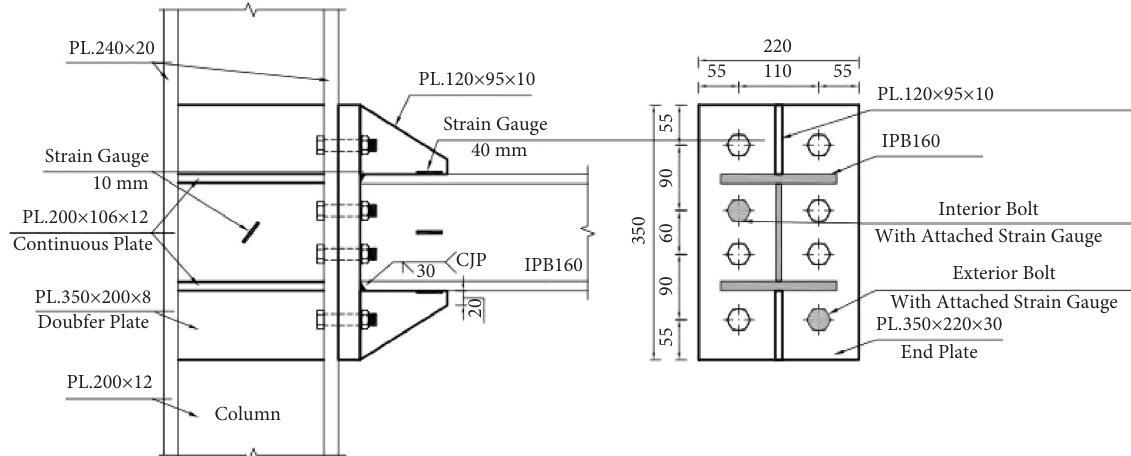
Figure 1: Properties of specimen-fabricating parameters and location of strain